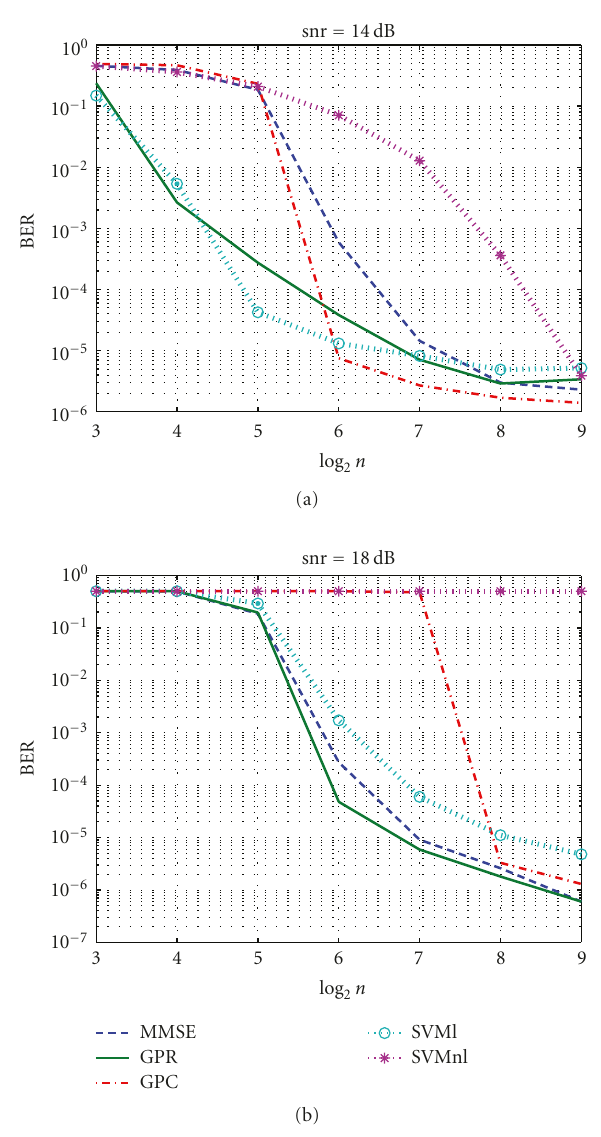
Figure 2: We report the BER versus the length of the training sequence for a multiuser detector with 3 users and snr = 14dB in (a) and 16 users and snr = 18dB in (b). The dashed line represents the linear MMSE receiver, the solid line the GPR, the dash-dotted line the GPC, the dotted line with circles the linear SVM, and the dotted line with bullets the nonlinear